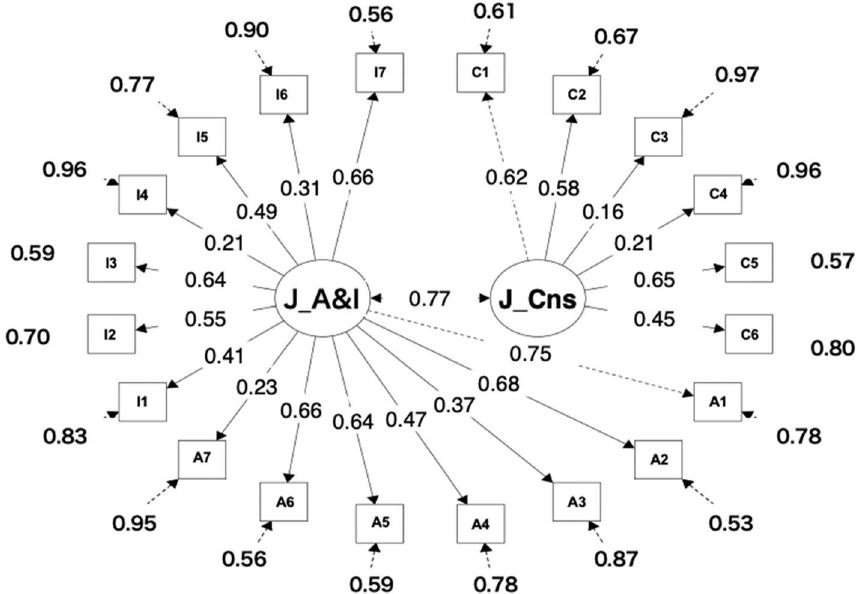
Fig. 3 Final two-factor correlated model for JCTT. Notes. All the estimates are standardized and significant ( p <.001); J_A&I JCTT Analysis and Inference; J_Cns = AGFI .88, SRMR .11, CFI 1.000, RMSEA = = =